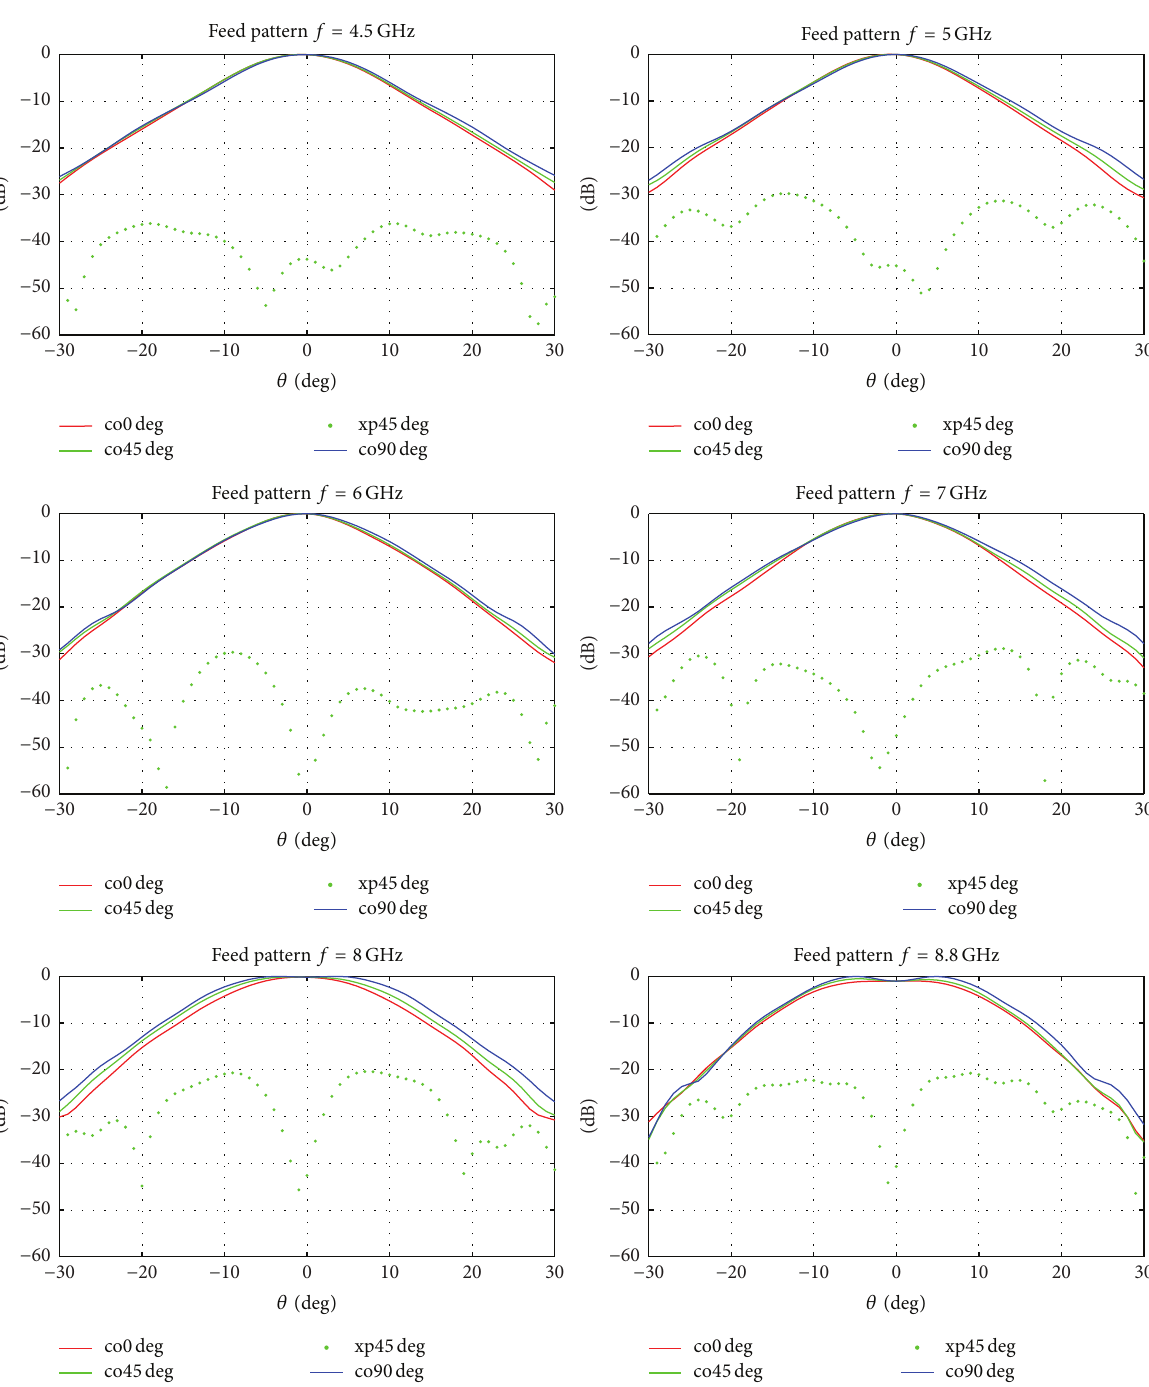
Figure 10: Measured beam pattern of feed (blue-copolar 𝐻 -plane, red-copolar 𝐸 -plane, green-copolar diagonal plane, and green dot-cross- polar diagonal